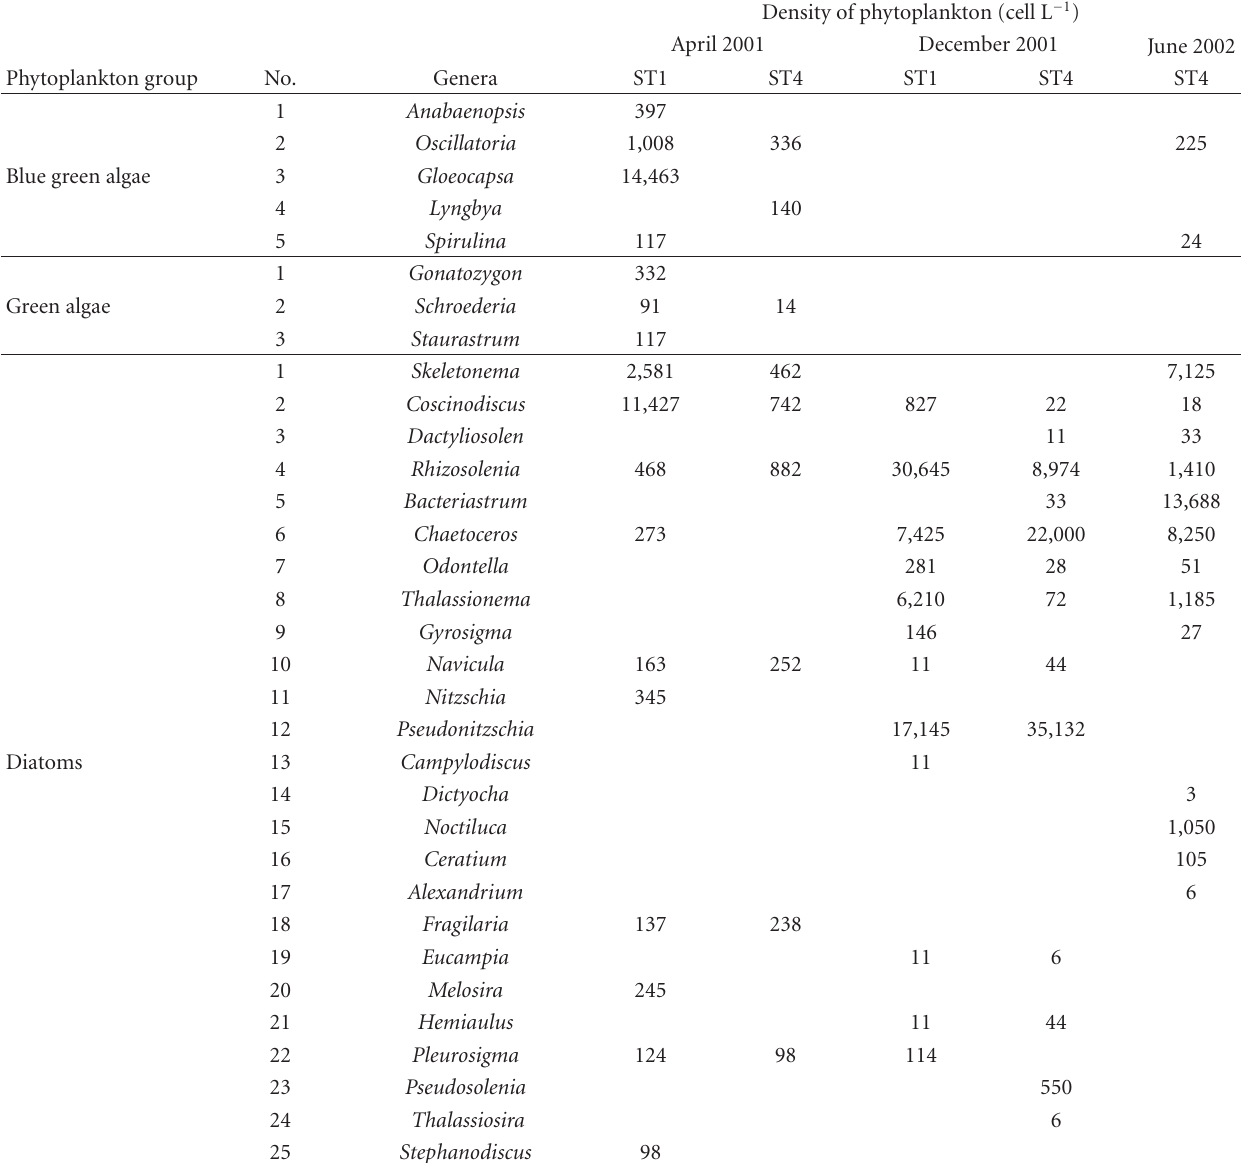
Table 5: Results of phytoplankton (cell L − 1 ) measurement conducted in April 2001, December 2001, and June